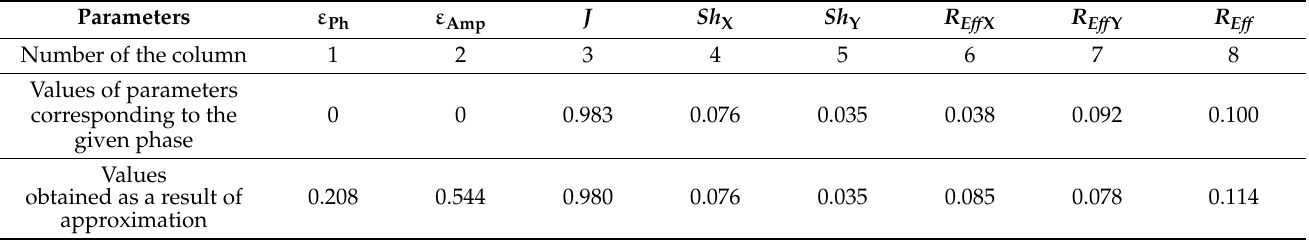
Table 7. Characteristics of the beam in the plane of observations calculated with increased turbulence intensity. Parameters of numeric experiment were the same as in the previous example (Figure